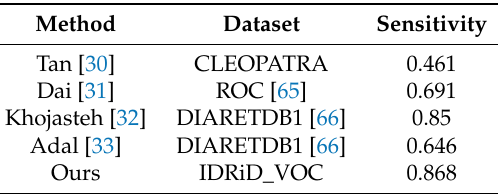
Table 7. Results of MA